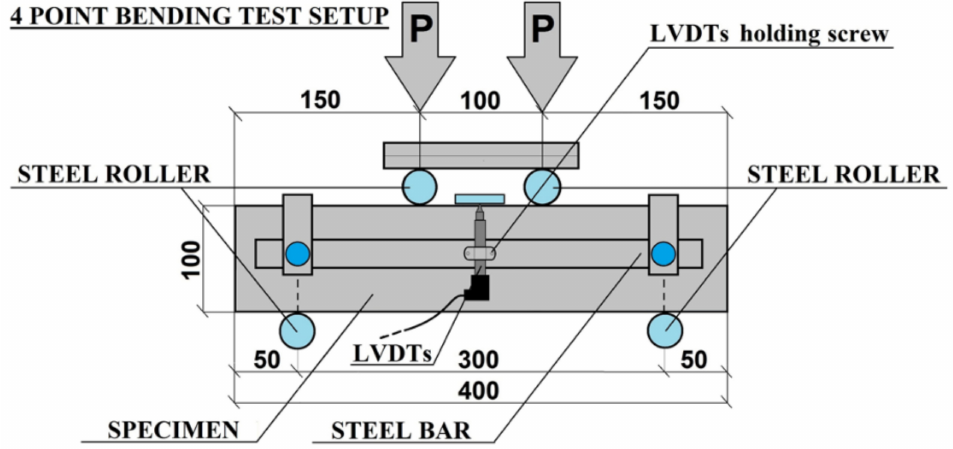
Figure 13. Four-point bending test scheme for testing of SFRC